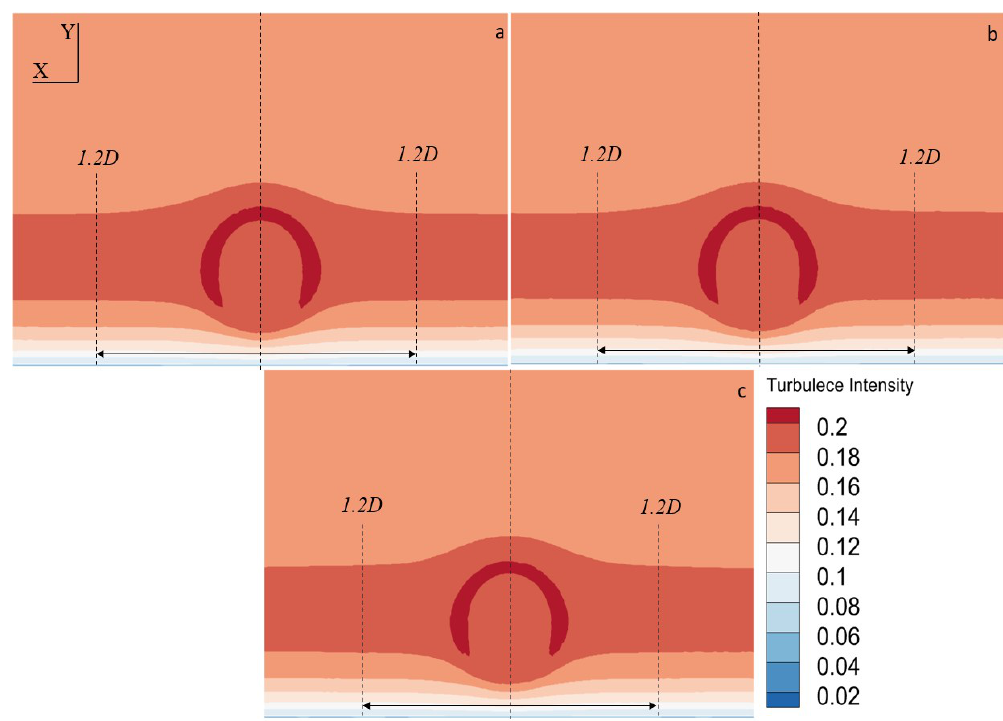
Figure 11. Turbulence intensity at z = 1 D ( a ) T / r = 0.0016 ( b ) T / r = 0.0032 ( c ) T / r = 0.0064.